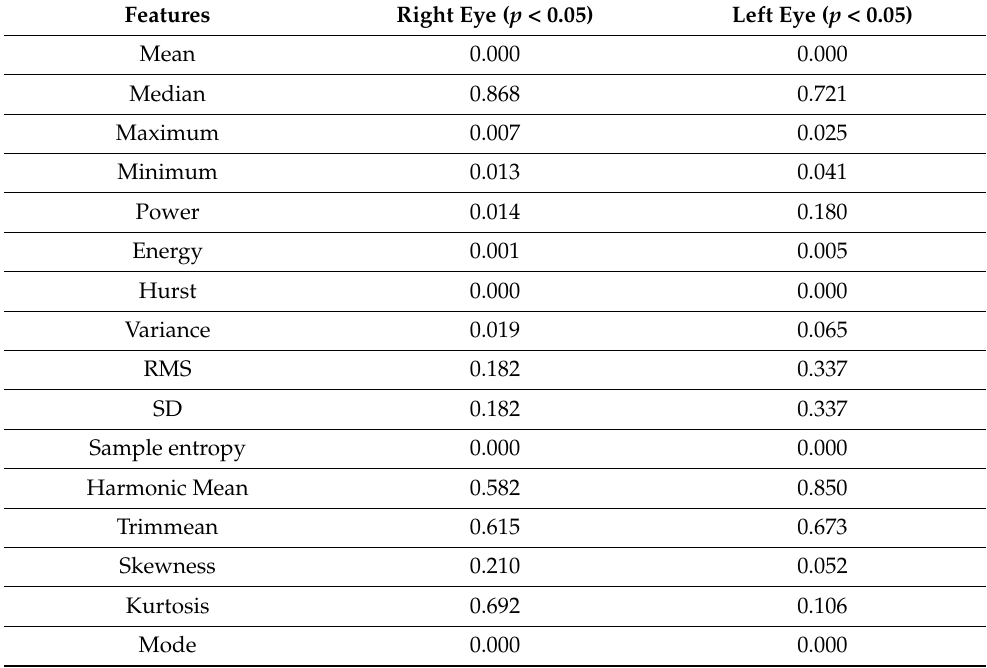
Table 2. EOG feature selection with